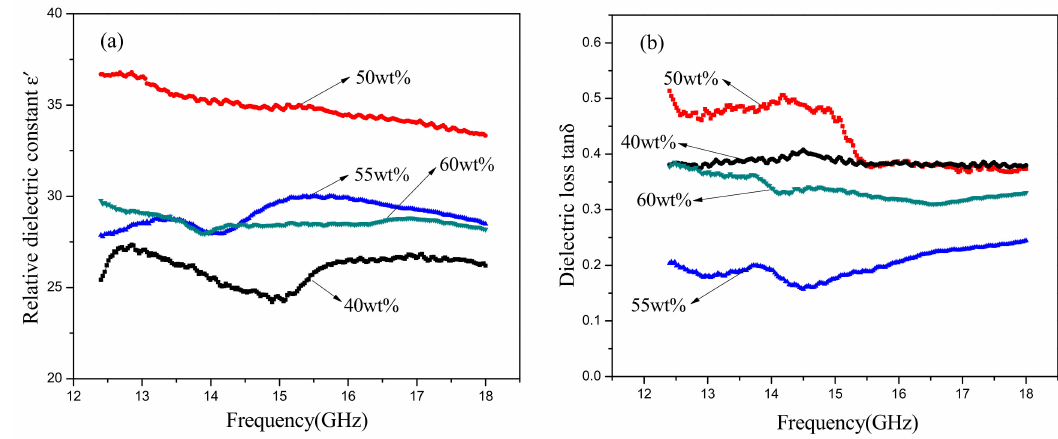
Figure 6. Dielectric properties of SiC-AlN ceramics with different SiC contents at high frequencies: ( a ) relative dielectric constant; ( b ) dielectric